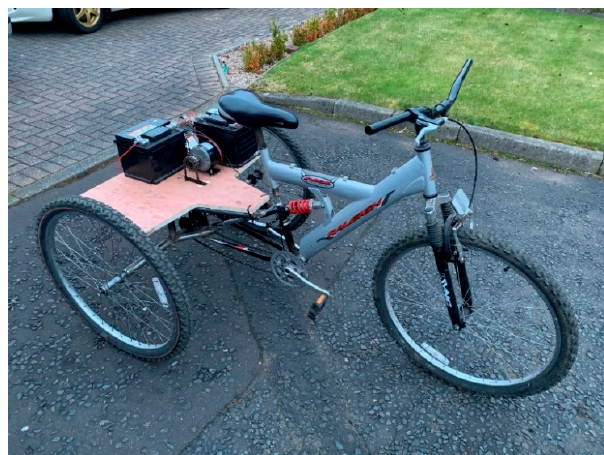
Figure 16. Finished prototype.